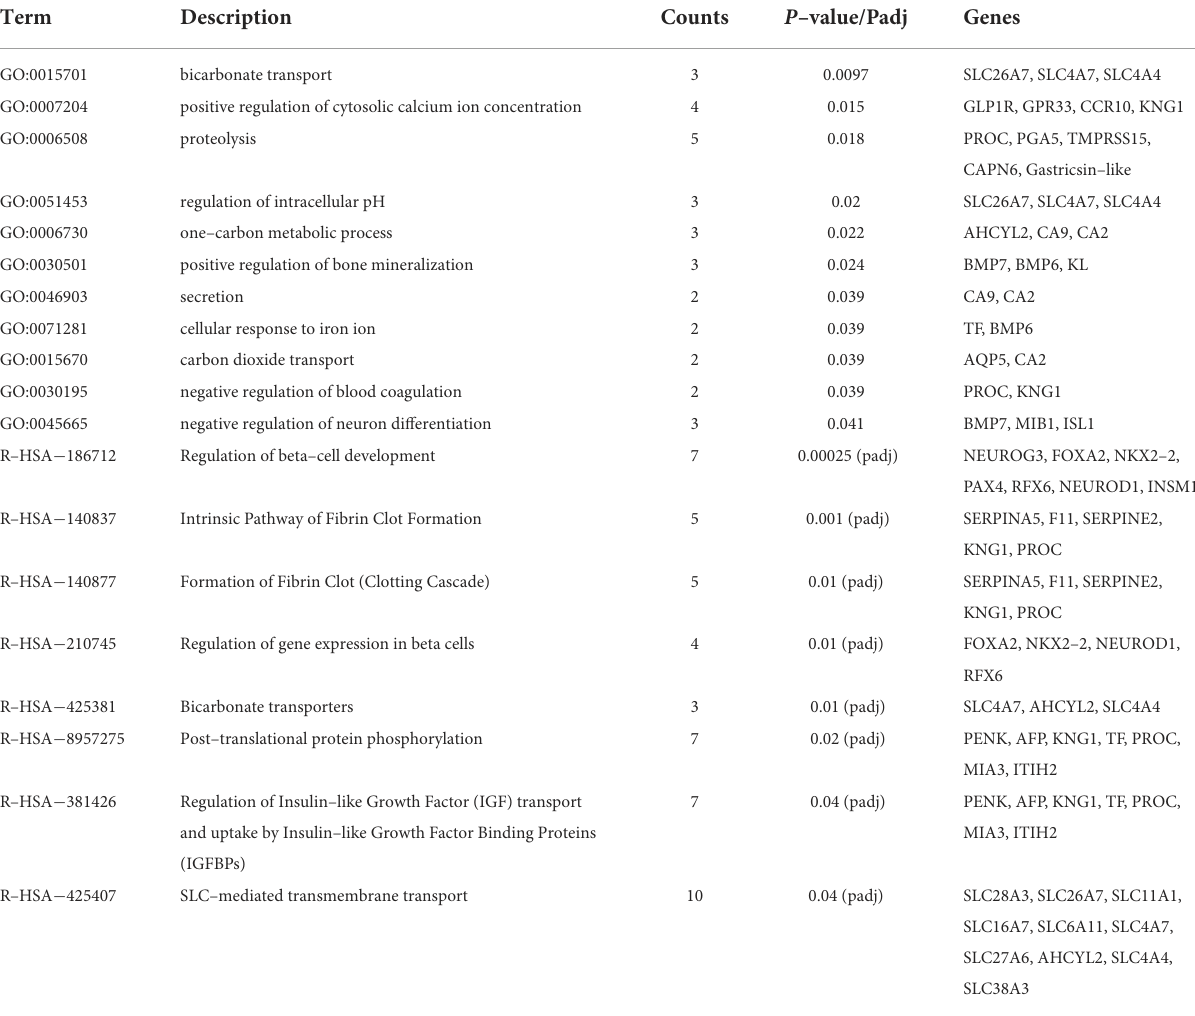
TABLE 3 Pathway analysis of the genes in the light–cyan consensus module. Term